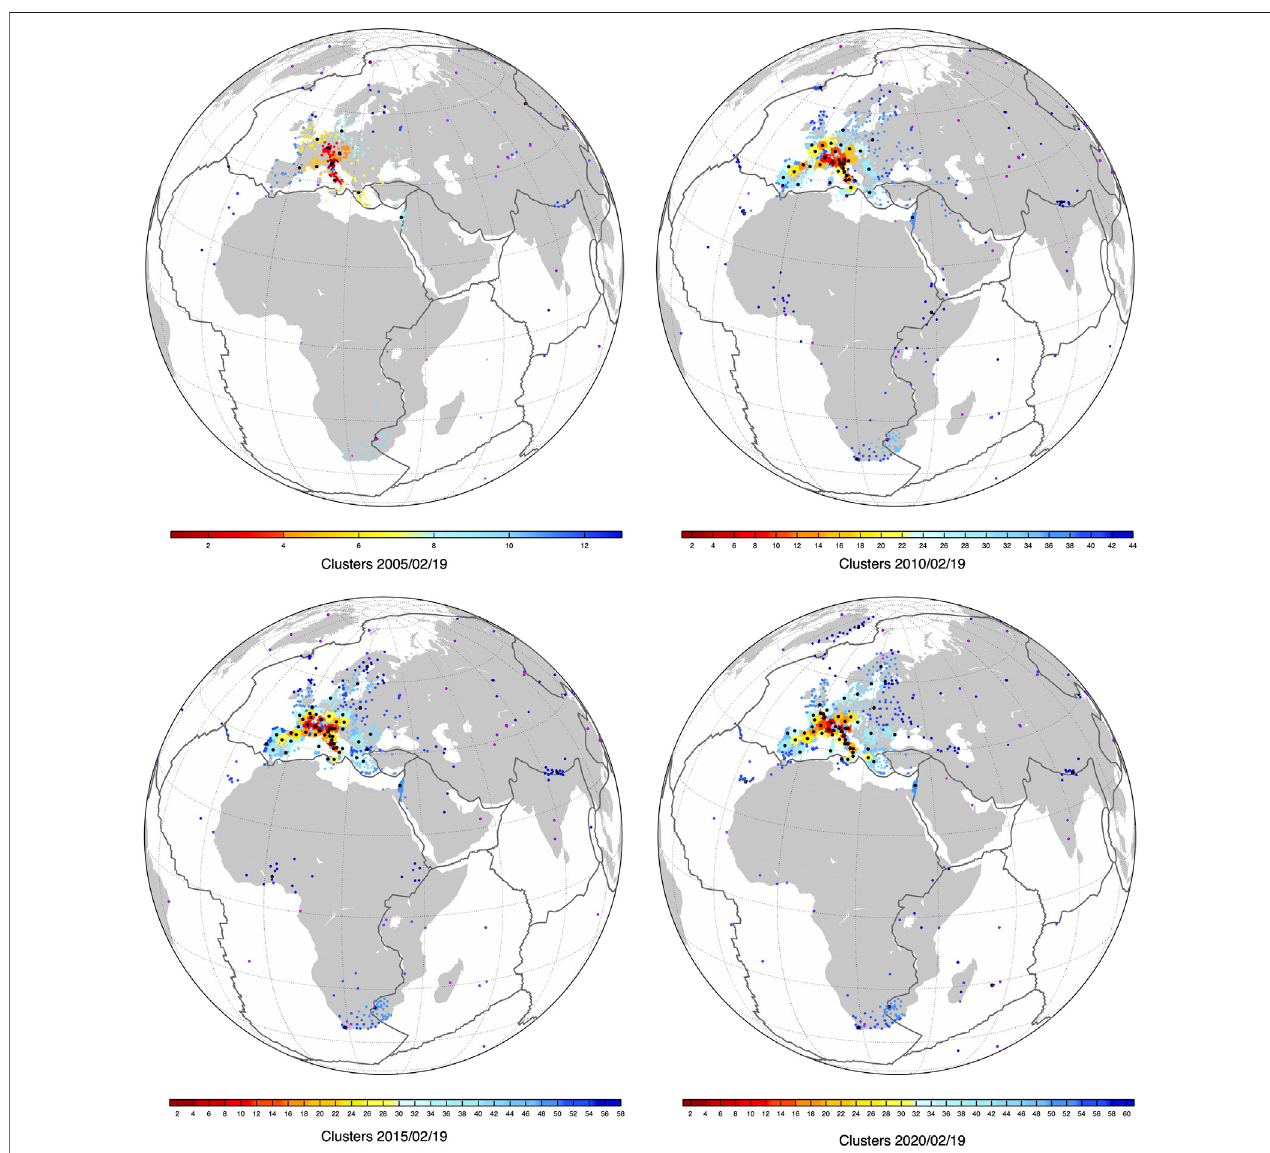
FIGURE 3 | Distribution of sub-networks (or daily clusters) for different epochs (day of year 050 of 2005, 2010, 2015, and 2020). The colors from red to blue represent the cluster ID/number. The black and purple circles show the tie-stations and the available IGb14-core sites, respectively.